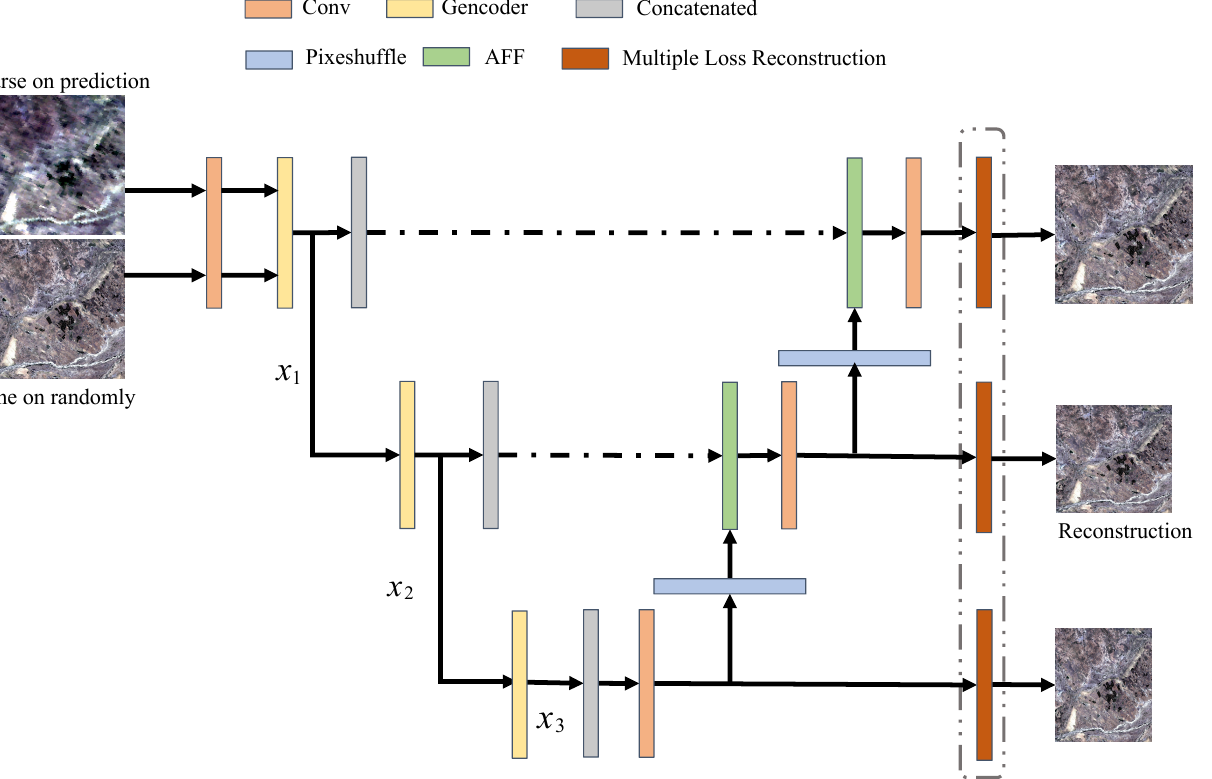
Figure 3. Overall structure of the generator ( x 1 , x 2 , x 3 represent different scale features,